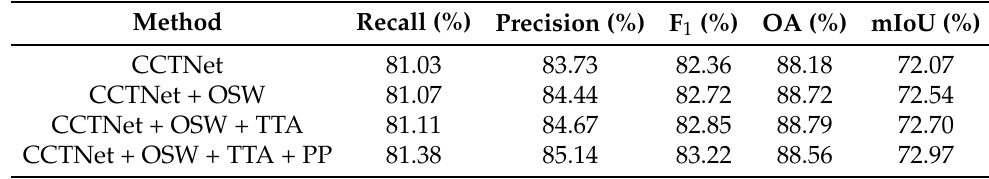
Table 9. Results of methods to improve performance during inference